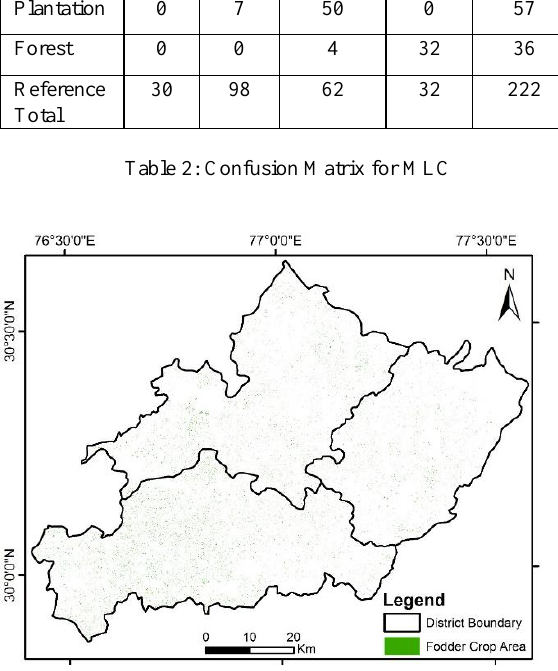
Figure 7. Area under Fodder